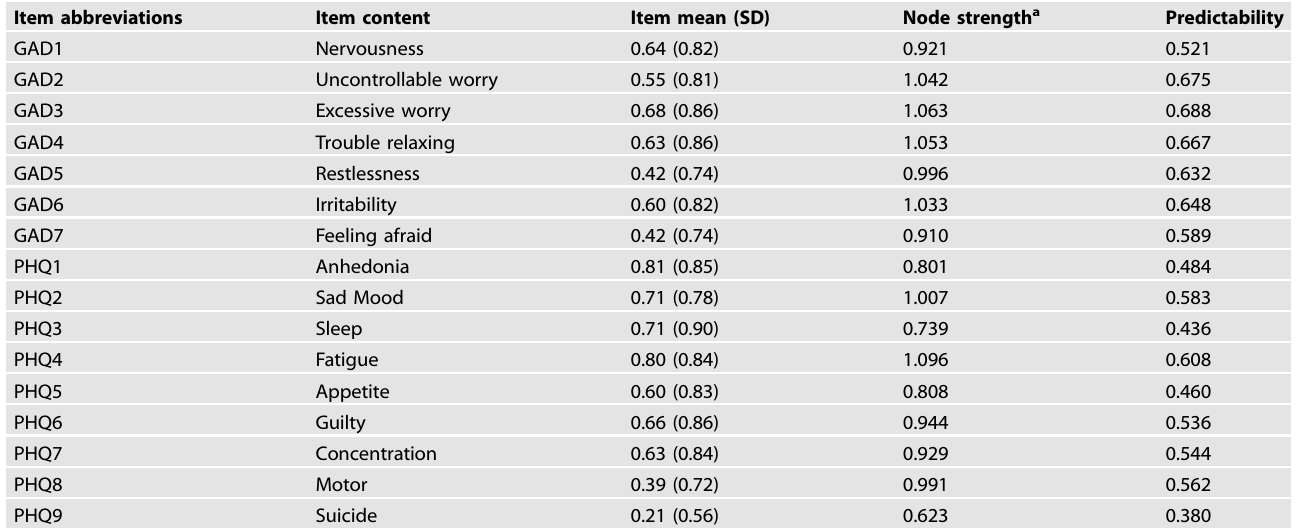
Table 1. Descriptive statistics of the PHQ-9 and GAD-7